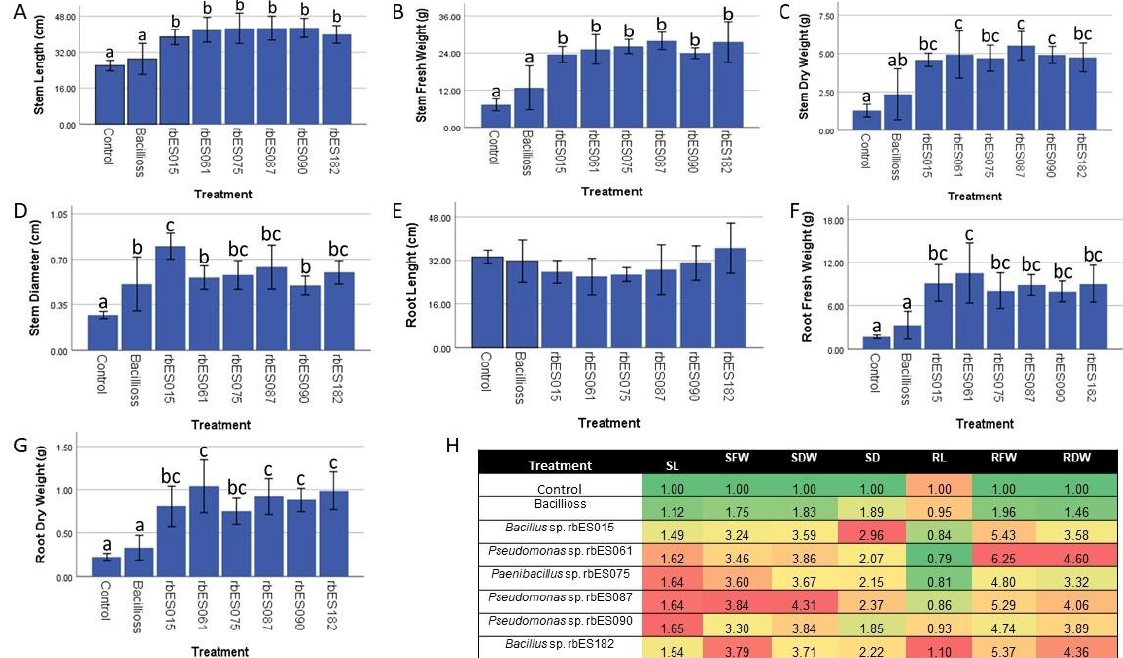
Figure 3. Effect of rhizobacteria inoculation on S. lycopersicum growth. ( A – G ) Effect of treatment of tomato plants with rhizobacteria strains on different plant growth indicators. Bars represent the mean of 8 plants ± SD per treatment. Different letters over bars indicate significant differences ( p < 0.05). ( H ) Fold change of evaluated variables of plants inoculated with different strains when compared to the negative control. Stem length (SL), stem fresh weight (SFW), stem dry weight (SDW), stem diameter (SD), root length (RL), root fresh weight (RFW), root dry weight (RDW).